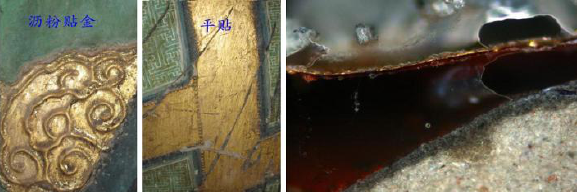
Figure 9 the microscopic cross-sectional structure of the pigment green and red in Main Hall mural